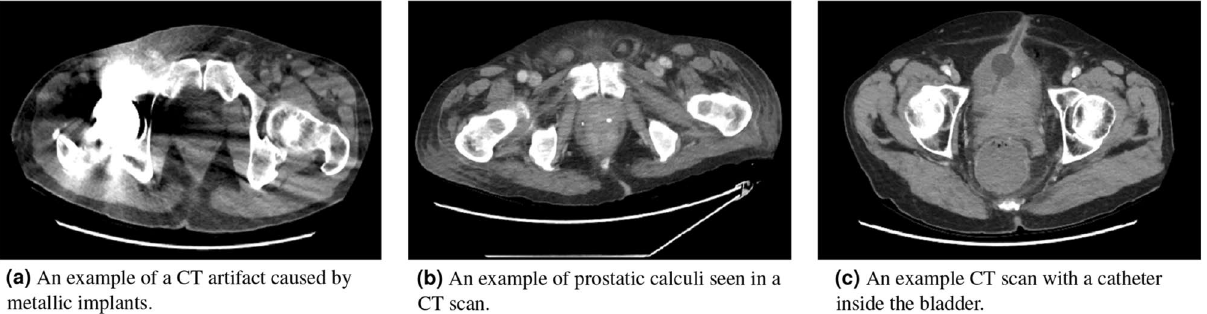
Figure 7. A set of examples showing different artifacts that were found within the dataset: metallic objects causing spikes of noise, calculi within the prostate, and